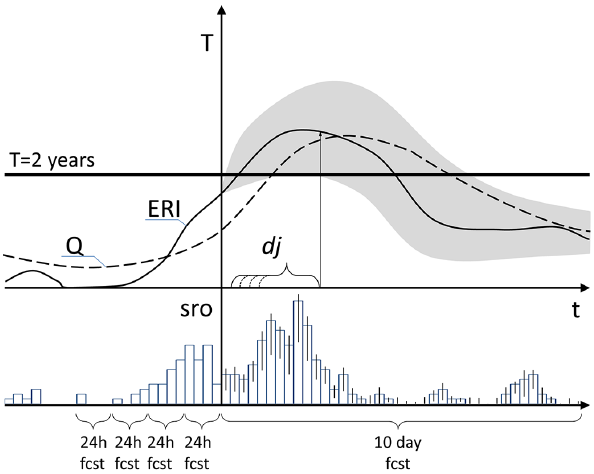
Figure 1. Schematic view of ERI forecasts and comparison with river discharge ( Q ). Sample input sro is shown at the